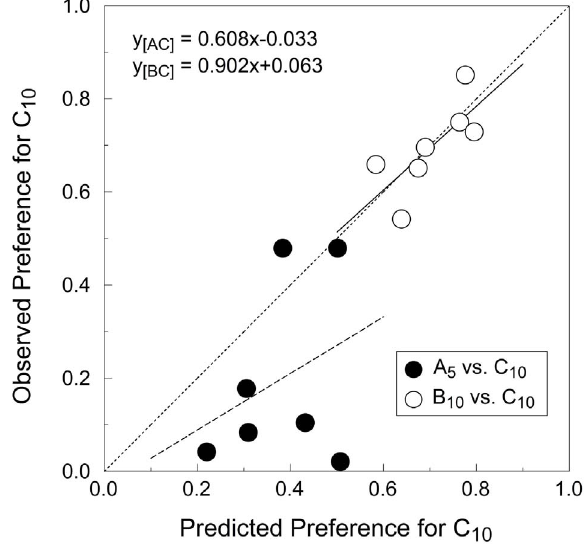
Figure 5. Overall fit of the SCM. Scatter plot of the preference for C 10 predicted by the SCM versus the observed preference for C 10 . Each dot represents one subject, with black and white dots referring to the A 5 vs. C 10 and B 10 vs. C 10 tests. Both lines are linear regressions.